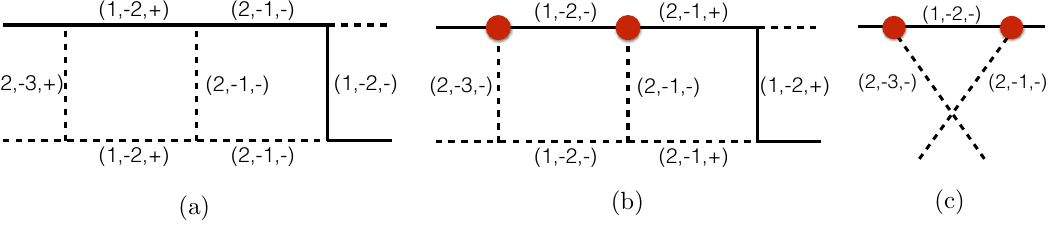
Figure 6. Example of two di(cid:11)erent models to explain the importance of Z 2 to forbid one-loop contributions: (a) two-loop contribution from model 1 of table 26 ( Z 2 assignment A), (b) two-loop contribution from model 2 of table 26 ( Z 2 assignment B), (c) one-loop contribution obtained from model 2 ( Z 2 assignment